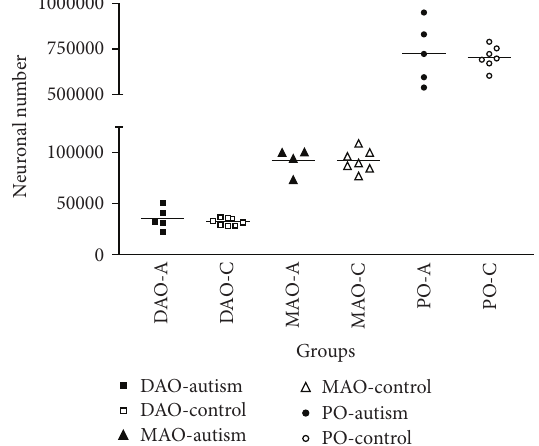
F 1: Scatter plot for neuronal number in the inferior olivary complex by group. No signi�cant di�erences were found for the IOC (DAO: dorsal accessory olive; MAO: medial accessory olive; PO: principle olive). A: autism, C: control. F 2: Photomicrographs of the inferior olive to show clustering